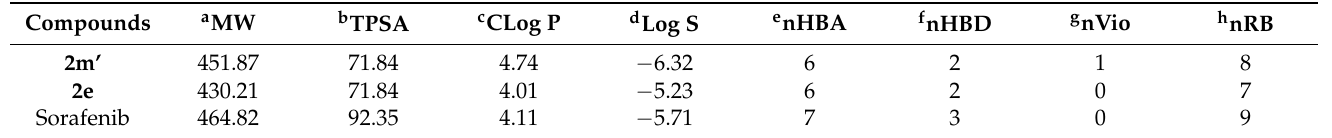
Table 2. The physicochemical properties of active compounds 2m’ and 2e compared with Sorafenib. Compounds a MW b